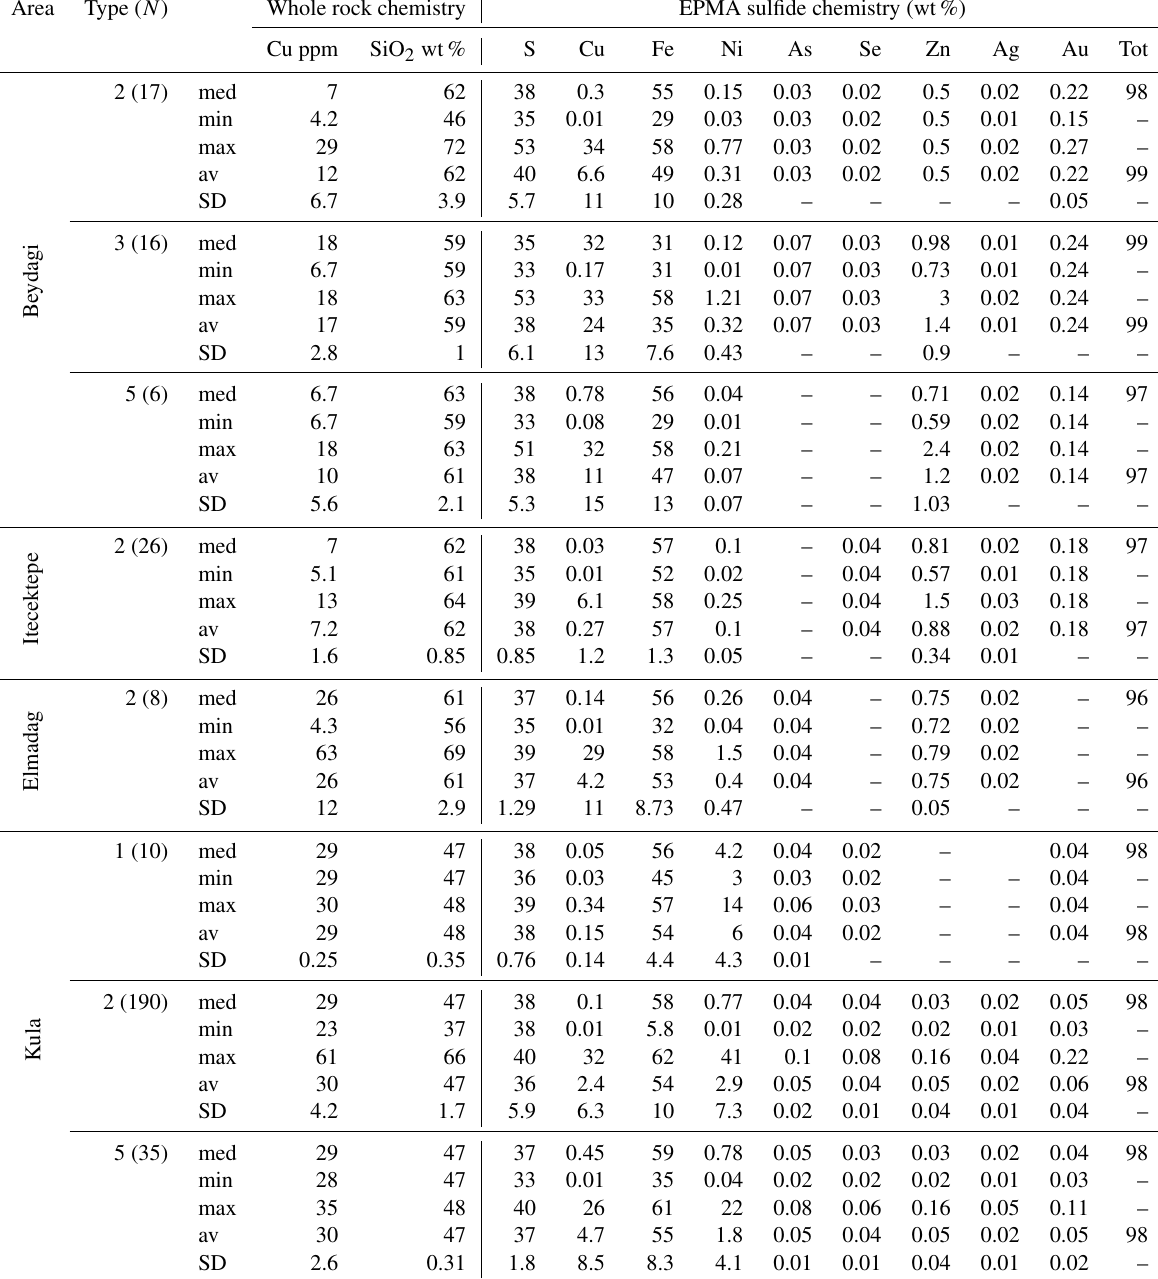
Table 1. EPMA summary for individual sulfide analysis ( N is the number of measurements) corresponding to each sulfide type for every study area. The empty cells (–) correspond to a lack of measurement either because it was below the determination limit or not measured. For the complete dataset, analytical conditions, and detection limits, see Table 4 from Georgatou and Chiaradia